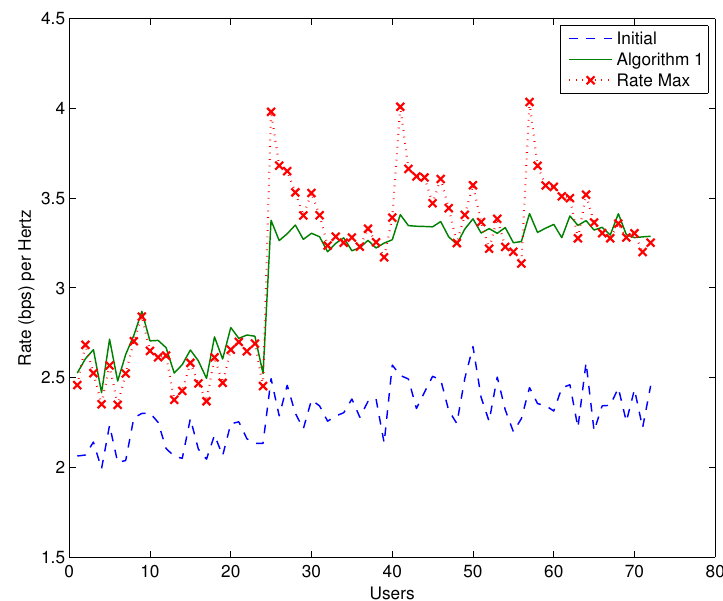
Figure 9. Comparison of Rate per Hertz (initial, Algorithm 1, Rate Max [26]).